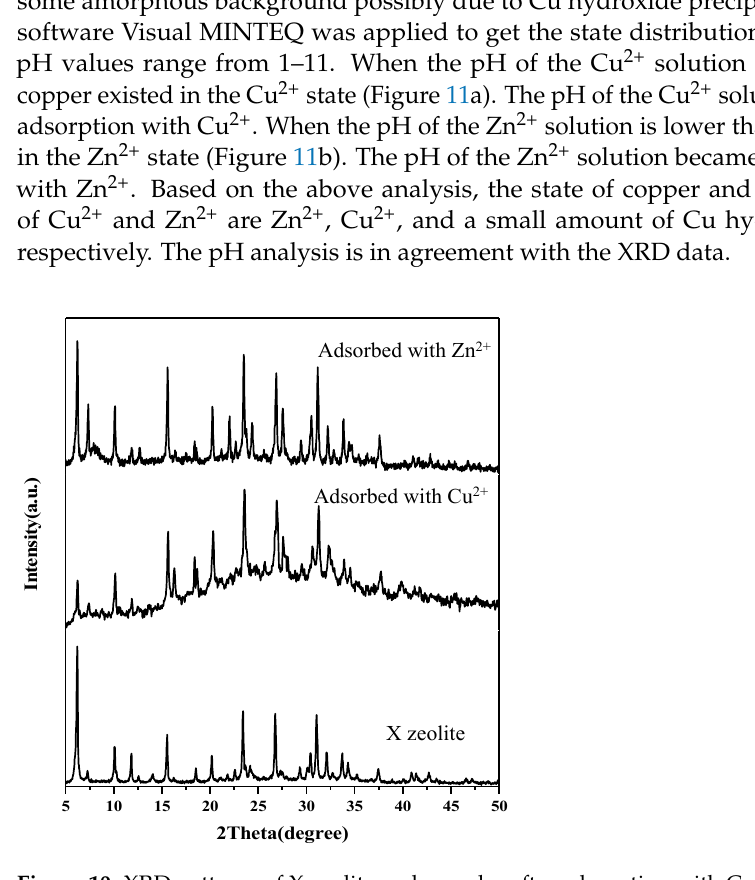
Figure 10. XRD patterns of X zeolite and samples after adsorption with Cu 2+ and Zn 2+ .